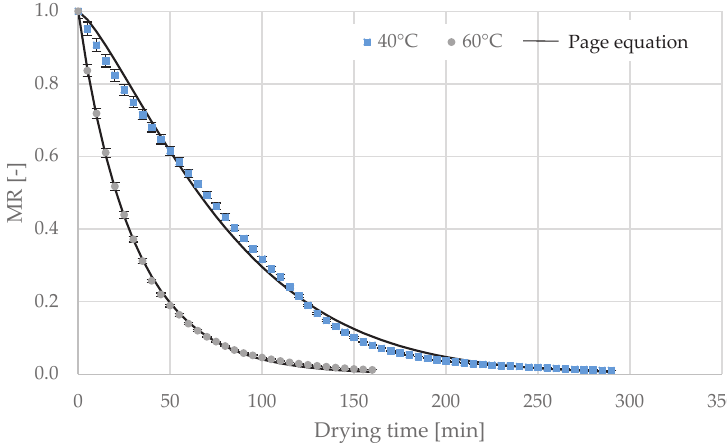
Figure 3. Drying curves of the air drying of Moldavian dragonhead.